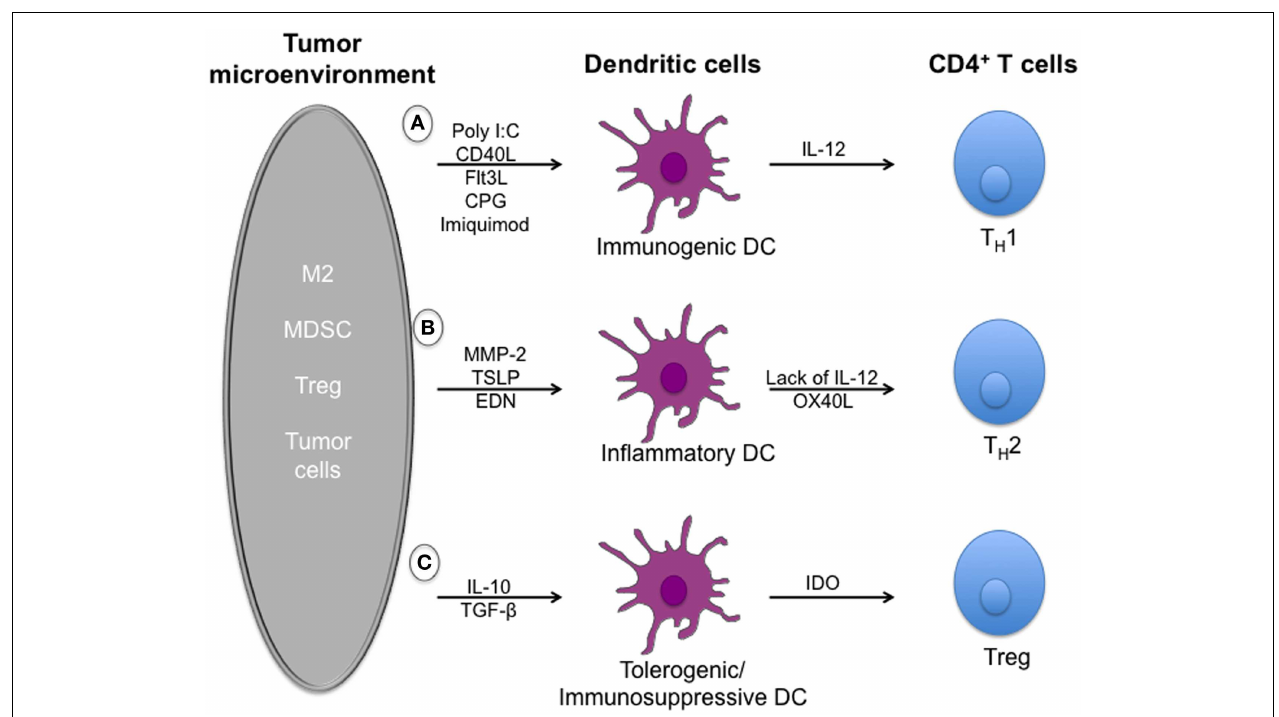
differentiation of naiveT cells intoT H 1 cells, and stimulates the production of interferon-gamma (IFN- γ ) and tumor necrosis factor-alpha (TNF- α ) fromT and NK cells cells. (B) In the tumor microenvironment, development of detrimental/suboptimalT H 2 cells is induced by alarmins such asTSLP, EDN, and MMP-2 through mechanisms depending on inflammatory DCs. (C) Immuno-suppressive cytokines such as IL-10 andTGF- β are responsible for the induction of immature/tolerogenic/immuno-suppressive DCs able to promote the accumulation of regulatoryT cells.Tregs play a crucial role in maintaining a suppressive environment and inhibiting anti-tumor